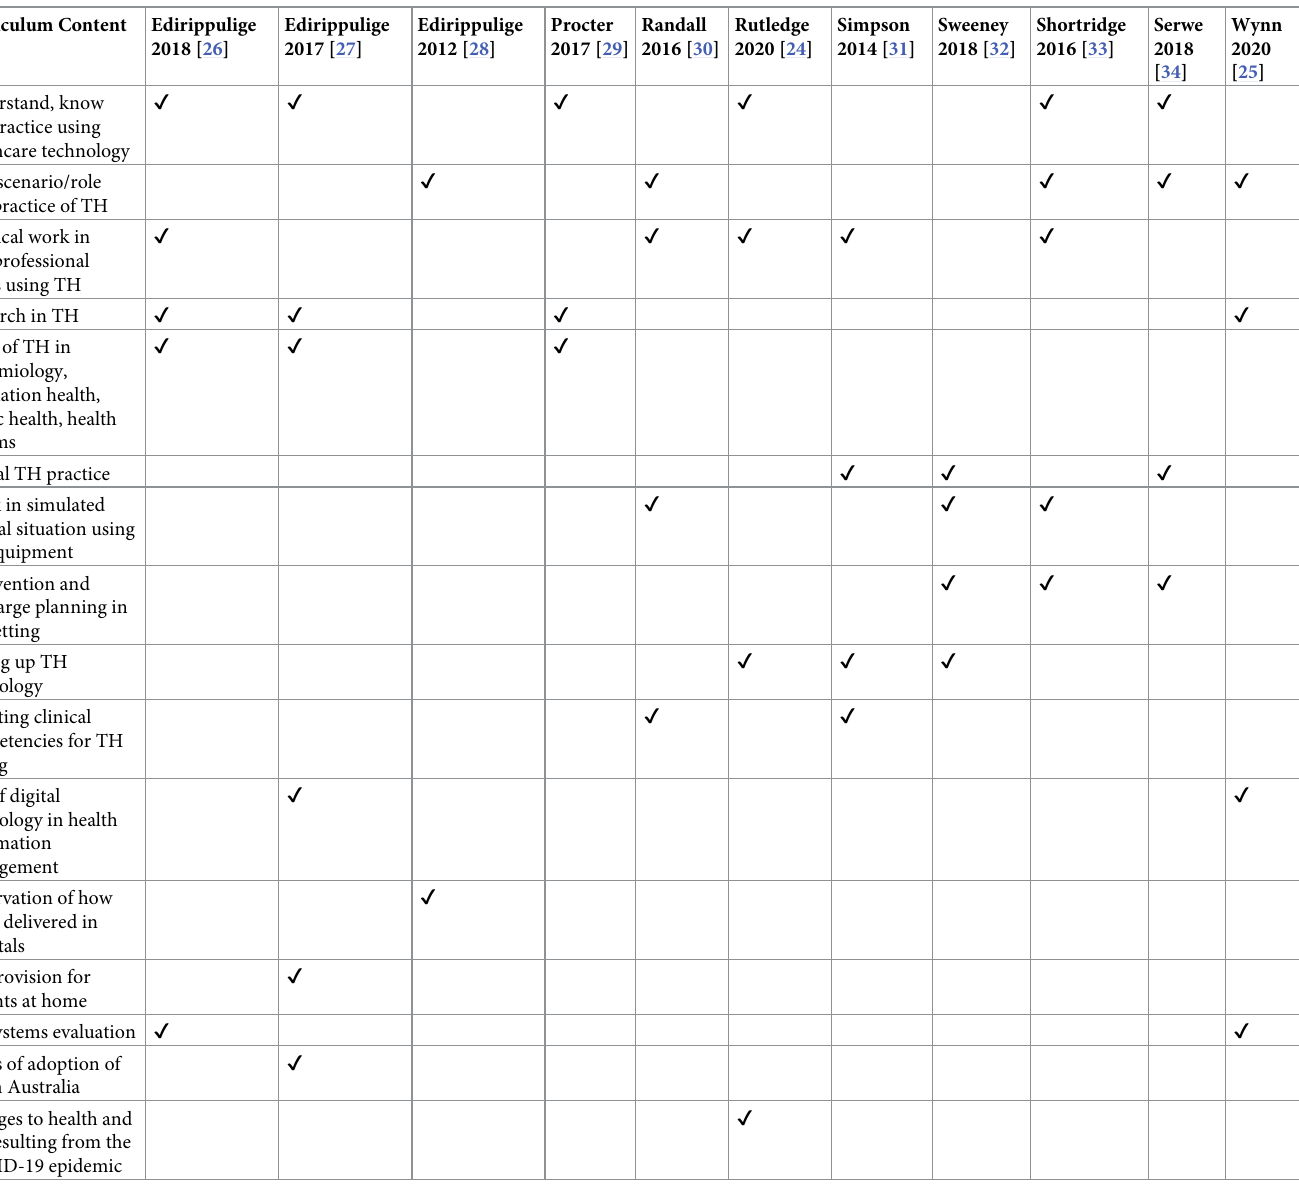
Table 4. Telehealth curricula content �